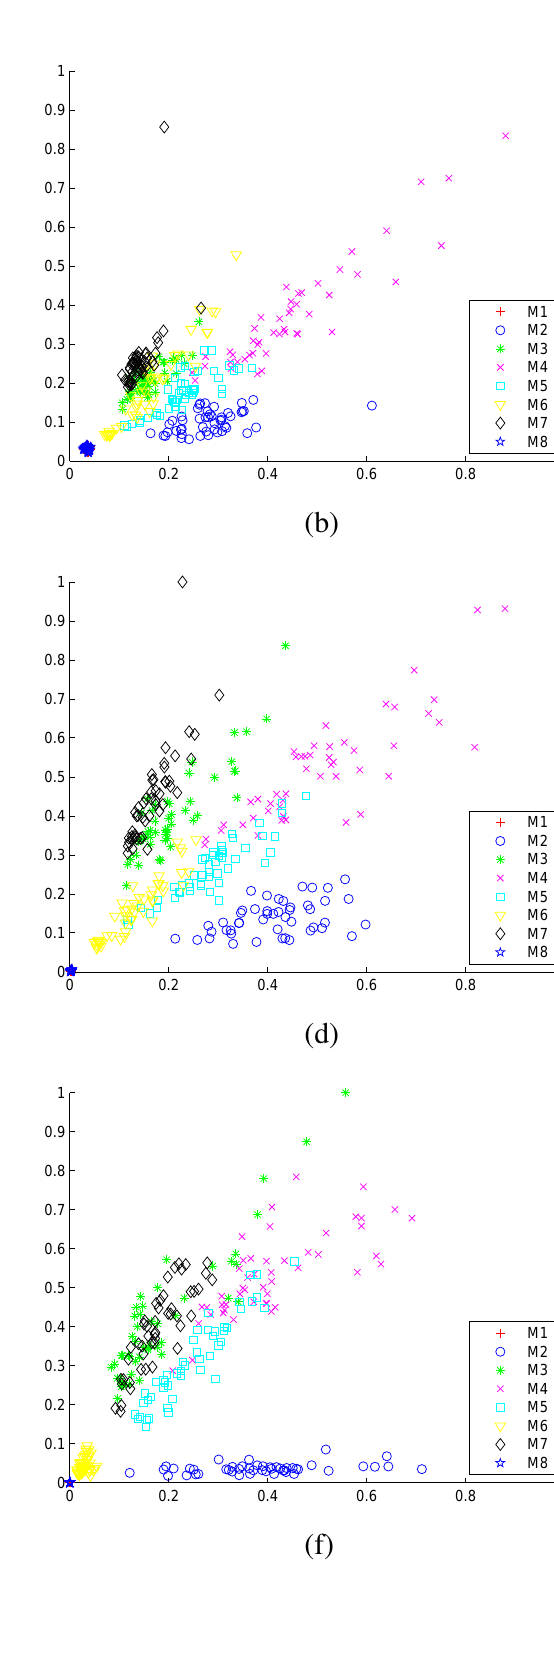
Figure 8. Scatter plots of the normalized variances of (a) A and (f) D over all motion types. Features extracted from the first and the second gyro signals 5 are plotted along the horizontal and the vertical axes of the plots,